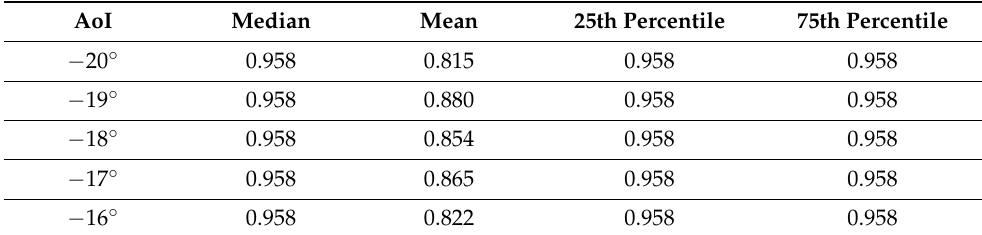
Table 5. Processed intensity data for orange transparent